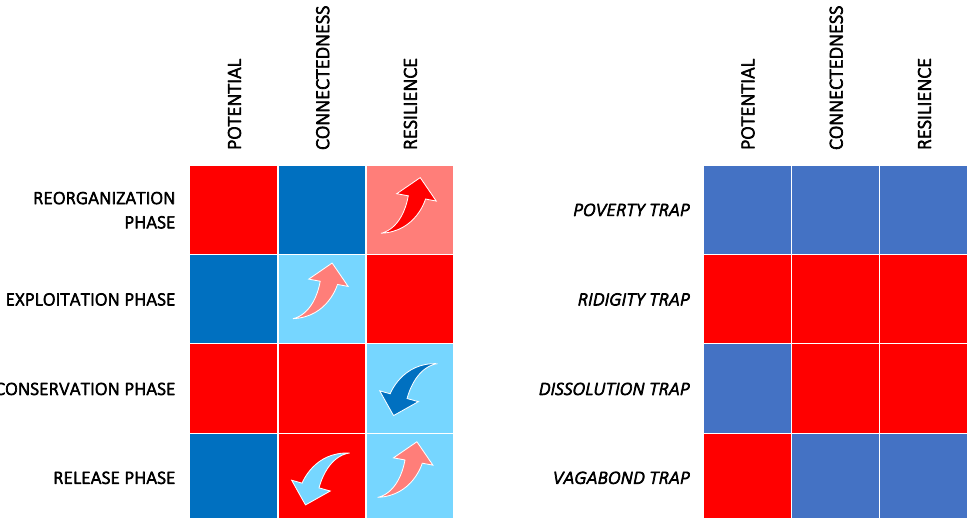
Figure 2. Four phases and pathological states of the adaptive